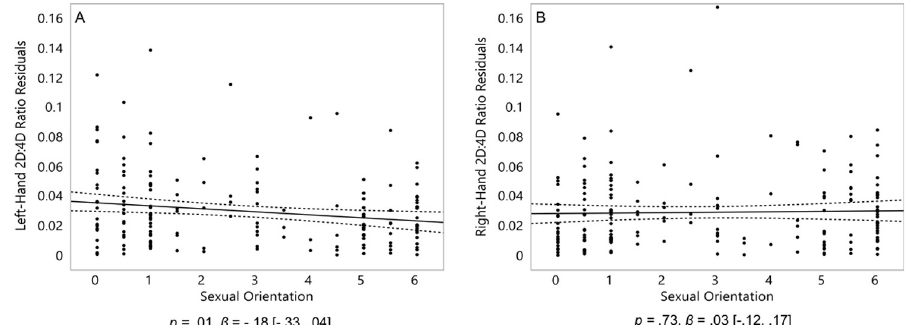
Fig 4. 2D:4D of 182 women. Absolute residuals derived from the effects displayed in Fig 2 for 2D:4D (left-hand 2D:4D, A; and right-hand 2D:4D, B). On the Y axis, residuals for 2D:4D, with higher scores representing a greater degree of variance from the main effect. On the X axis, 0 represents exclusive heterosexuality, 3 represents bisexuality, and 6 represents exclusive homosexuality. Triple lines represent regression coefficients with their 95% confidence intervals. Dots represent participants’ residuals. Statistics represent linear